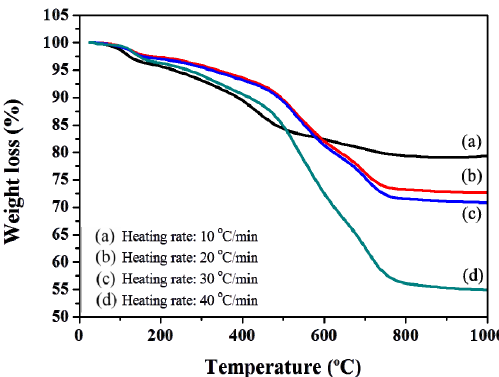
Fig. 7 TGA curves of thermal decomposed behavior for cured PCS fiber at different heating rates.